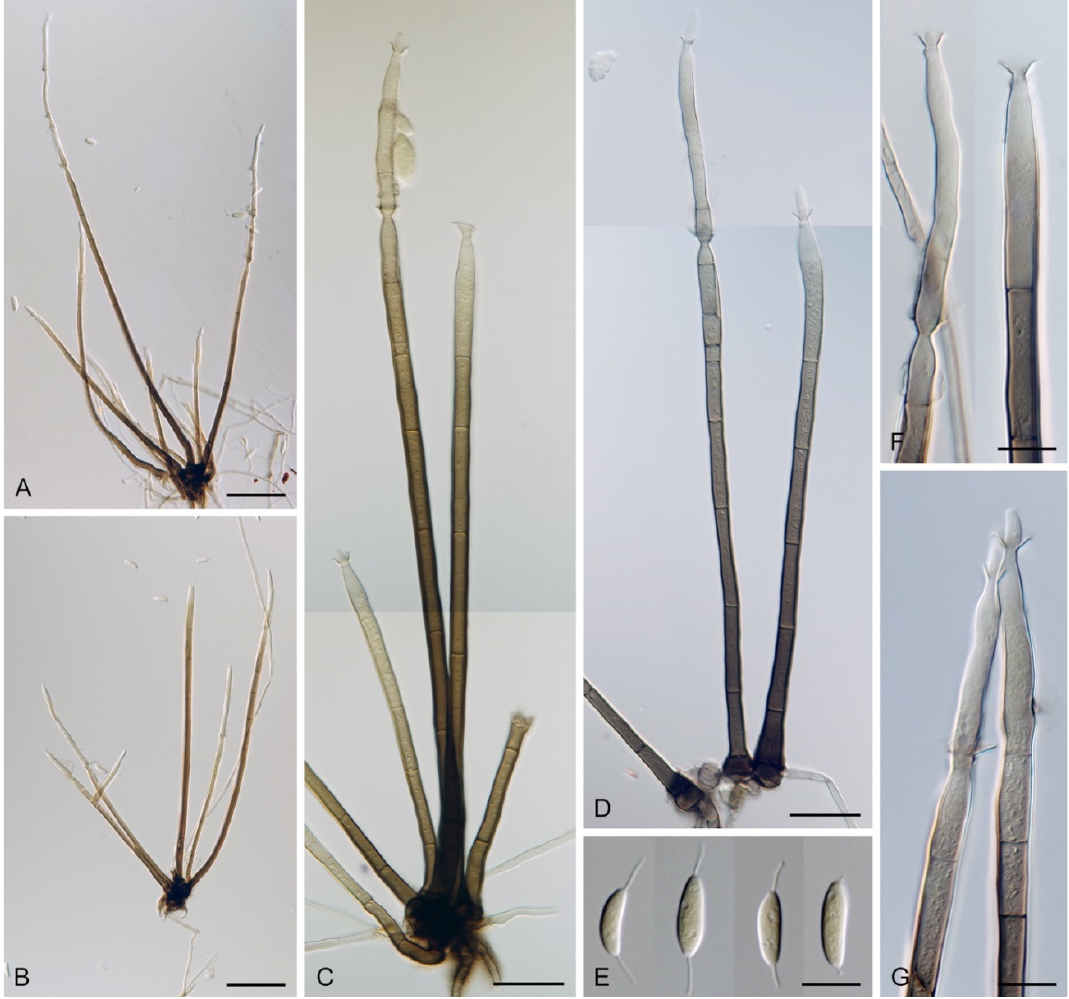
Figure 16. Codinaea fertilis (IMI 233824). ( A – D ) Setae with conidiophores ( E ) conidia ( F , G ) conidiogenous cells at the tip of the setae. Images: ( A – G ) on PCA after 6 weeks. Scale bars: ( A , B ) = 50 μ m; ( C , D ) 20 μ m; ( E – G ) 10 μ m. ≡ Dictyochaeta fertilis (S. Hughes & W.B. Kendr.) Hol.-Jech., Folia geobot. phytotax. 19: 426. 1984.